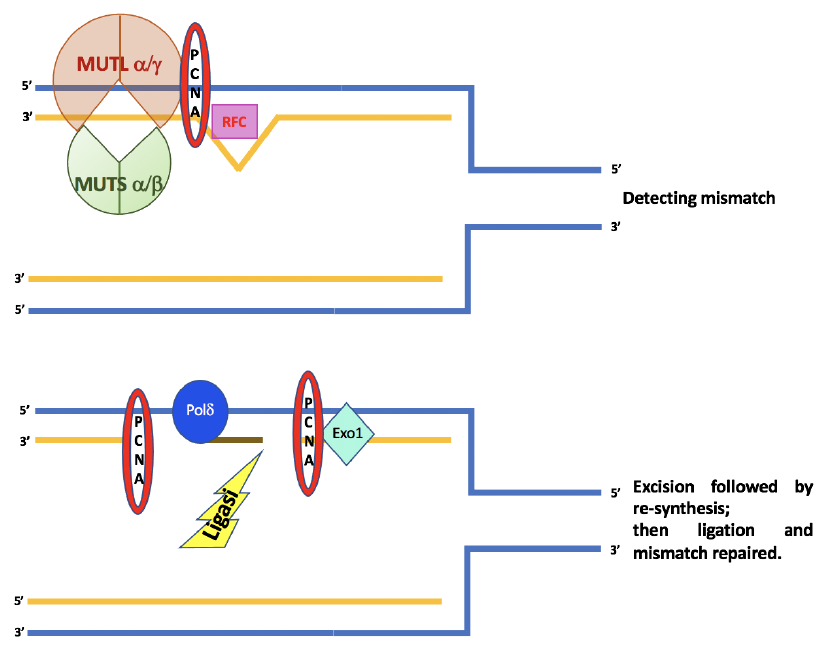
Figure 1. A schematic diagram for mechanisms and functions of human DNA mismatch repair.